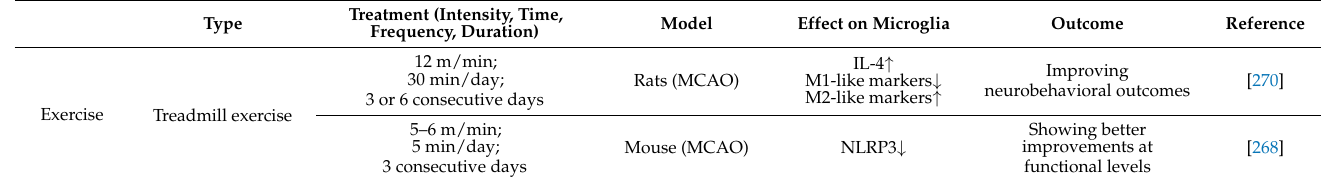
Table 4. Exercise and NIBS as the main rehabilitative interventions can promote post-stroke recovery by targeting microglia. ↑ , upregulate; ↓ , downregulate; MCAO, middle cerebral artery occlusion; dM- CAO, distal MCAO; PT, photothrombosis; rTMS, repetitive transcranial magnetic stimulation; tDCS, transcranial direct current stimulation; TUS, transcranial ultrasound stimulation; tFUS, transcranial focused ultrasound stimulation; TBS, theta-burst stimulation; HIT, high-intensity; MOD, moderate- intensity; IL-4, interleukin-4; NLRP3, NOD-like receptor thermal protein domain associated protein 3; IL-10, interleukin-10; p75NTR, P75 neurotrophin receptor; BDNF, brain-derived neurotrophic factor; IFN- γ , interferon- γ ; Gal-3, galectin-3; Syn, synaptophysin; PSD-95, postsynaptic density protein 95; TGF- β , transforming growth factor- β ; VEGF, vascular endothelial growth factor; HIF-1 α , hypoxia- inducible factor-1 α ; TLR4, toll-like receptor 4; NF- κ B, nuclear factor kappa-B; STAT6, signal